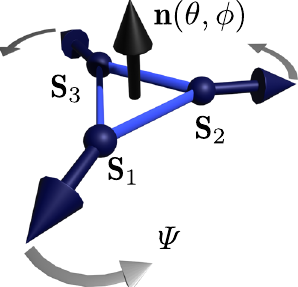
Fig. 2 The 120° spin order. The order parameter is described by the polar and azimuthal angles, θ and ϕ , of the vector chirality Þ , and the angle Ψ of the spin rotation around n density of the effective model is Fig. 1 b ) and q . The second term with J ? ¼ J z ¼ 3 ffiffi 4 p 3 J 2 results from the exchange interactions between the Fe- 2 triangles in the ab layers (Fig. 1 a ). The distances in the direction parallel(perpendicular) to the c -axis of the hexagonal lattice are measured in units of the lattice constant, c ( a ). D i ψ ¼ ∂ i ψ þ cos θ ∂ i ϕ is the covariant derivative of ψ ( i = x , y , z ) invariant under an arbitrary global rotation of spins. The third term in Eq. (3), playing the role of an internal magnetic fi eld, originates from DM interactions between spins in the triangles [see Eq. (2)] and the fourth term is the magnetocrystalline anisotropy. The next